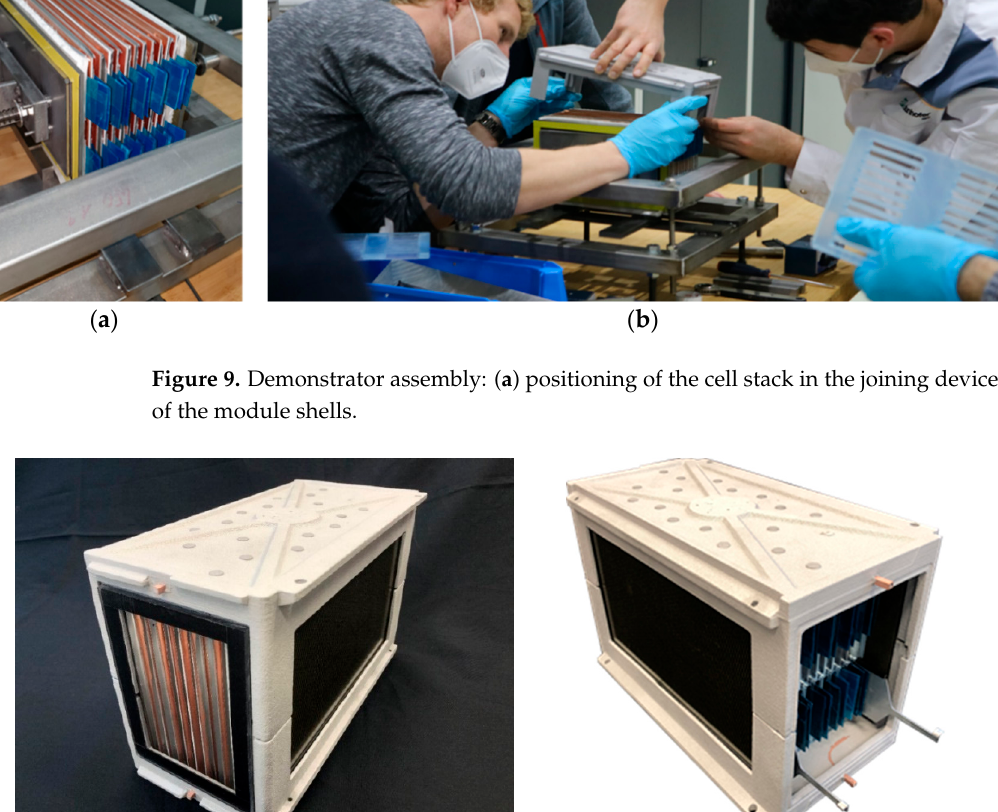
Figure 10. Demonstrator of the battery module. Left : rear view with window to provide insight into the module. Right : front view with stacked battery pouch cells and without cover. module to remove the pouch cells) can be carried out with the above-mentioned device.